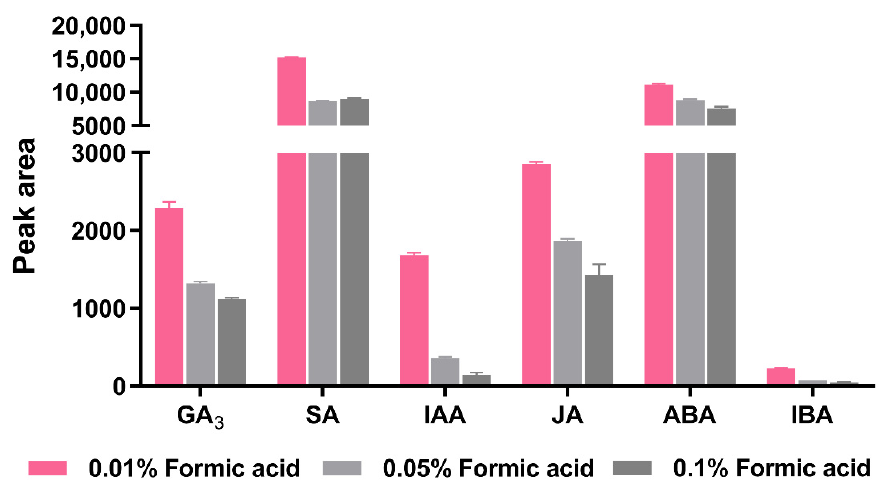
Figure 2. Peak area comparison of acidic hormones when using water and ACN with different contents of FA as mobile phase ( n = 3).